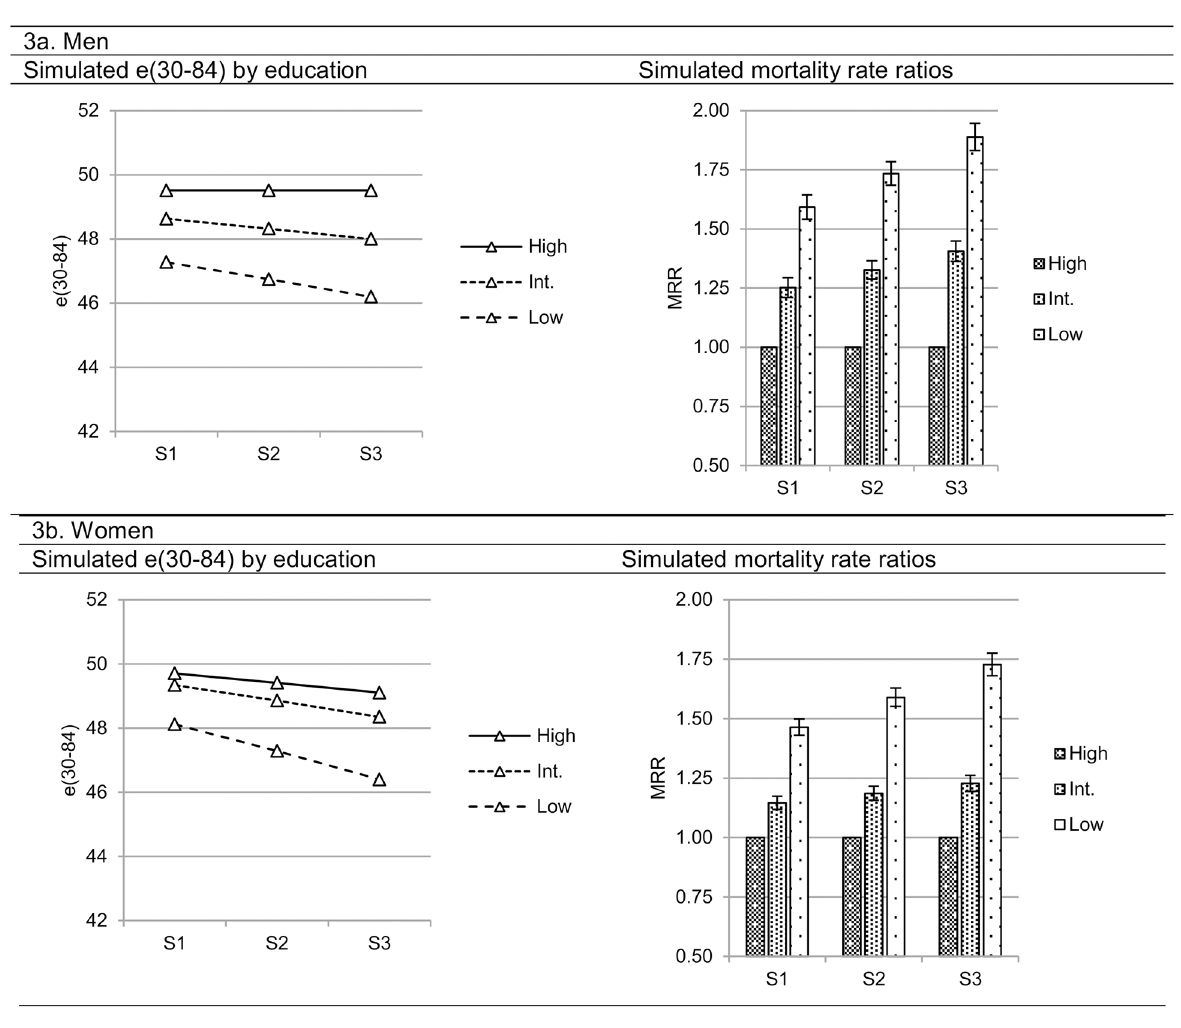
Fig 3. Simulated life expectancies between 30 and 84 yearsand mortality rate ratios at Scenario 1, 2, and 3, men and women.